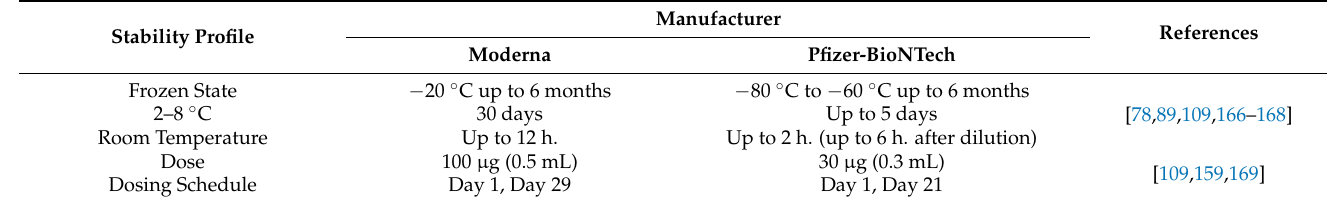
Table 4. Current mRNA COVID-19 vaccine Stability profile, dose, and dosing schedule.